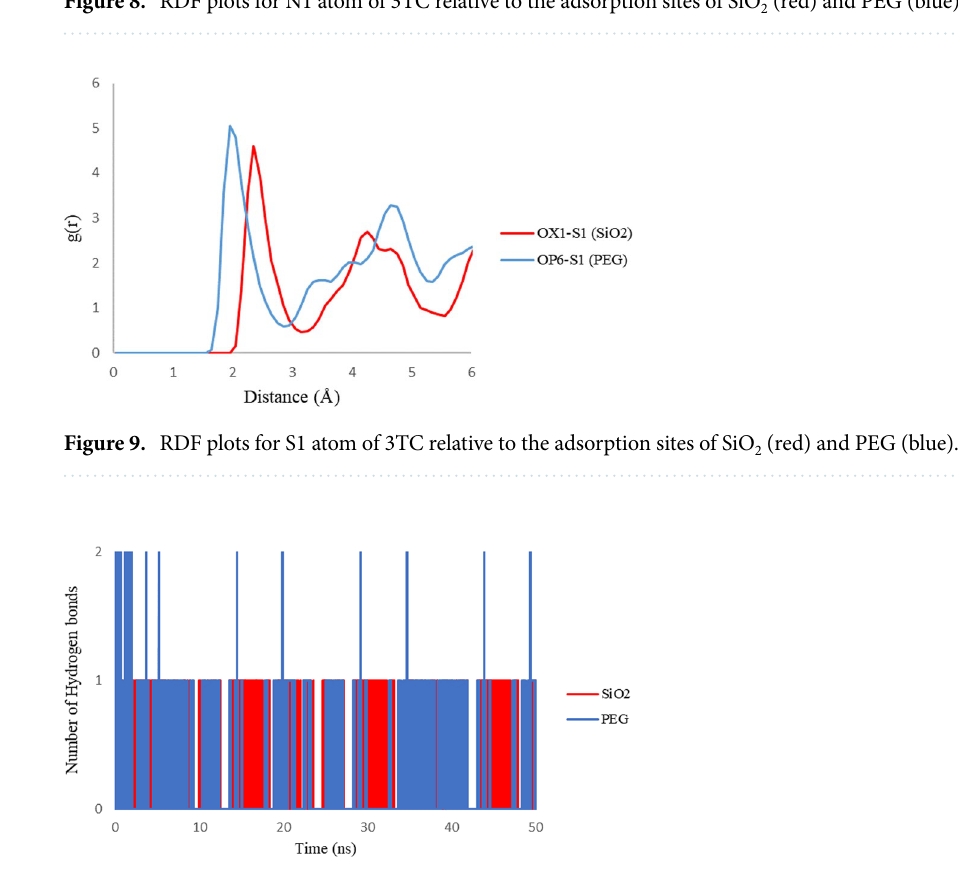
Figure 8. RDF plots for N1 atom of 3TC relative to the adsorption sites of SiO 2 (red) and PEG (blue).